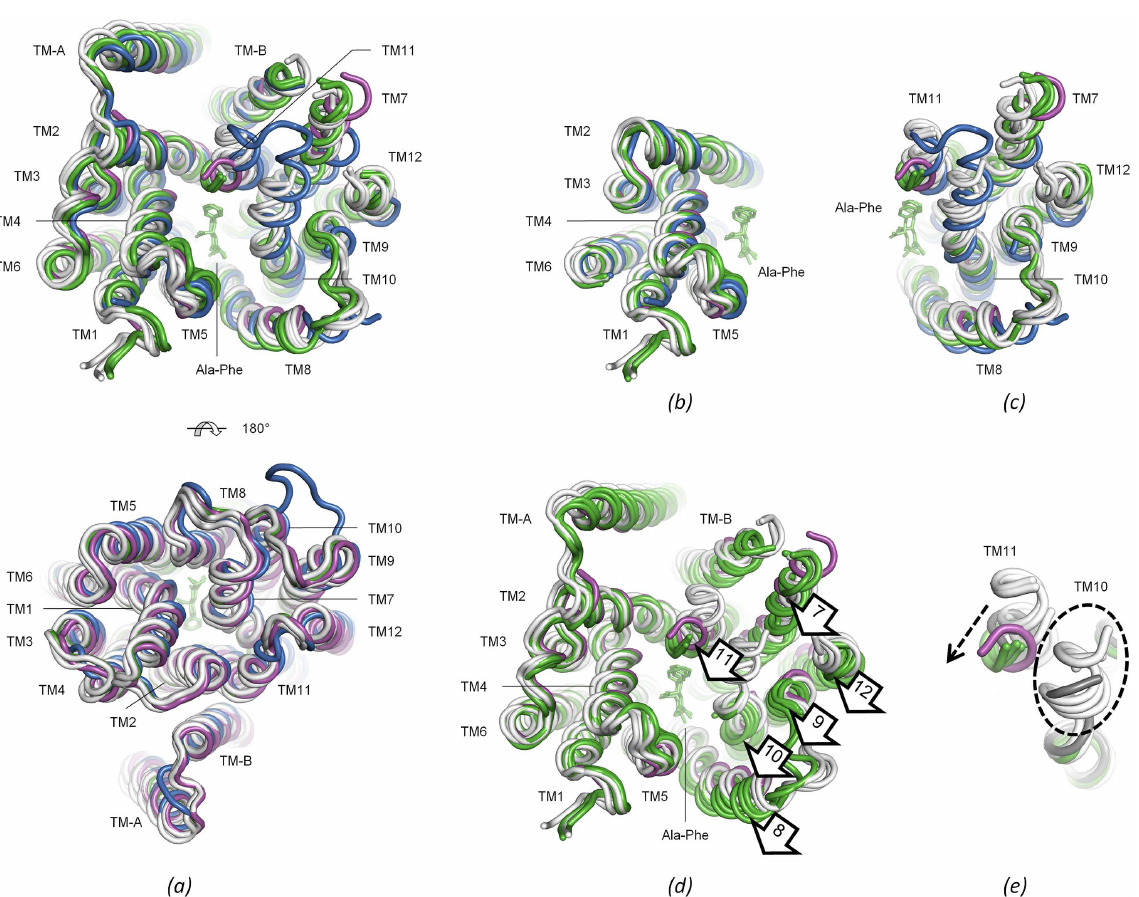
Fig 5. Structural comparisons. (a) All previously determined PepT St structures superimposed on the P3 1 21 structure (see also Table 5). The P3 1 21 structure is magenta, the P2 1 2 1 2 1 structure is blue the C222 1 structures with dipeptidesare green (dipeptides are shown in sticks), and the C222 1 structures without dipeptidesare white. Two views are shown—cytoplasmic(top) and periplasmic (bottom). (b) Superimposition of the N-domainsof the same structures used in panel a . (c) Superimposition of the C- domainsof the same structures used in panel a . (d) Same as in panel b , except that the C-domainsare shown alongsidethe superimposed N-domainsand that the P2 1 2 1 2 1 structure was omitted. A rotation of the C-domainrelative to the N-domaincan be recognized for the C222 1 structures with dipeptides(rotation marked with arrows). (e) Same as in panel c , except that only TM10 and TM11 are shown, that the C222 1 structure determinedat room temperature is grey, and that the P2 1 2 1 2 1 structure was omitted. The C222 1 structures with dipeptides, the P3 1 21 structure and to some extent the C222 1 structure determined at room temperature, show bending of TM11 (indicatedwith a dashed arrow) and increaseddisorderin TM10 (indicatedwith a dashed oval) relative to the other C222 1 structures determinedat